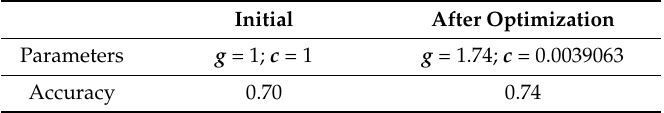
Figure 10. Flowchart of parameter optimization. Table 3. Accuracy of the recognition model tested on Taihu Lake.